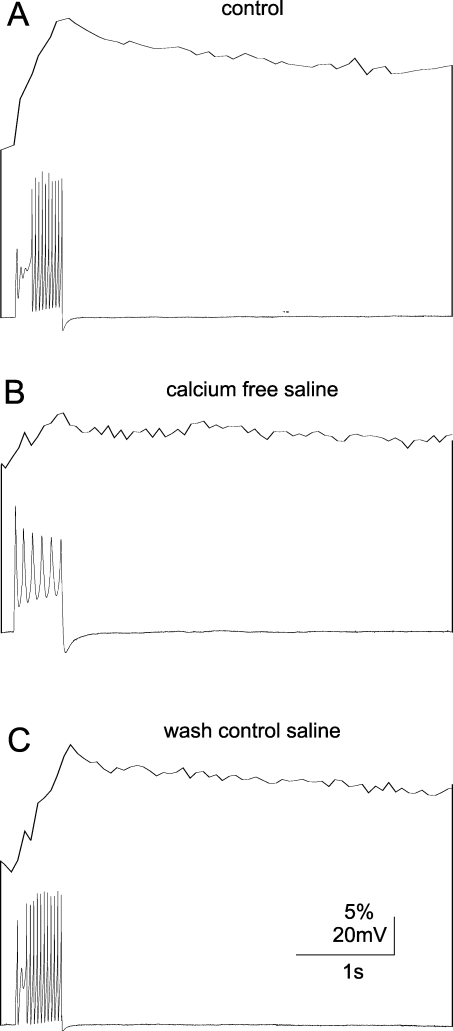
Bursts of Action Potentials Induce Intracellular Calcium Elevations in the Absence of Calcium Influx(A) In normal extracellular saline, a burst of action potentials (lower trace) induced by current injection of 0.5 nA is accompanied by a large elevation in intracellular calcium (upper trace).(B) Action potential shape and frequency are altered after 3 min in zero-calcium extracellular saline, but bursts are still accompanied by an elevation in intracellular calcium, although the calcium signal is slower and of lower amplitude as compared to (A).(C) Switching back to normal saline for 3 min restores signals as observed in (A).